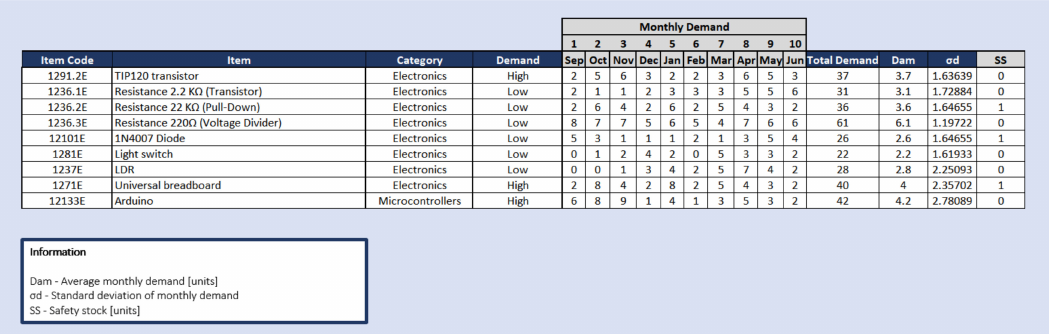
Figure 7. “Safety Stock”